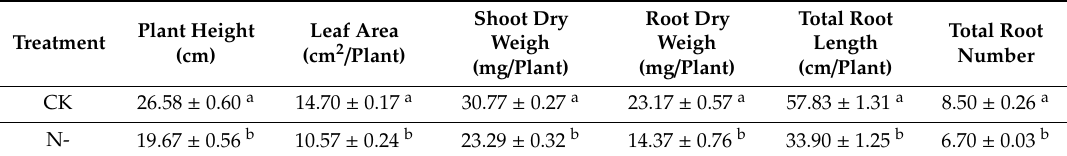
Table 1. E ff ects of low nitrogen stress on plant height, leaf area, shoot dry weight, root dry weight, total root length, and total root number of wheat seedlings. Di ff erent treatments represent: The control (CK), low nitrogen stress (N-). The data are from the average of 15 seedlings, for each parameter, mean values ( ± standard error) are presented.